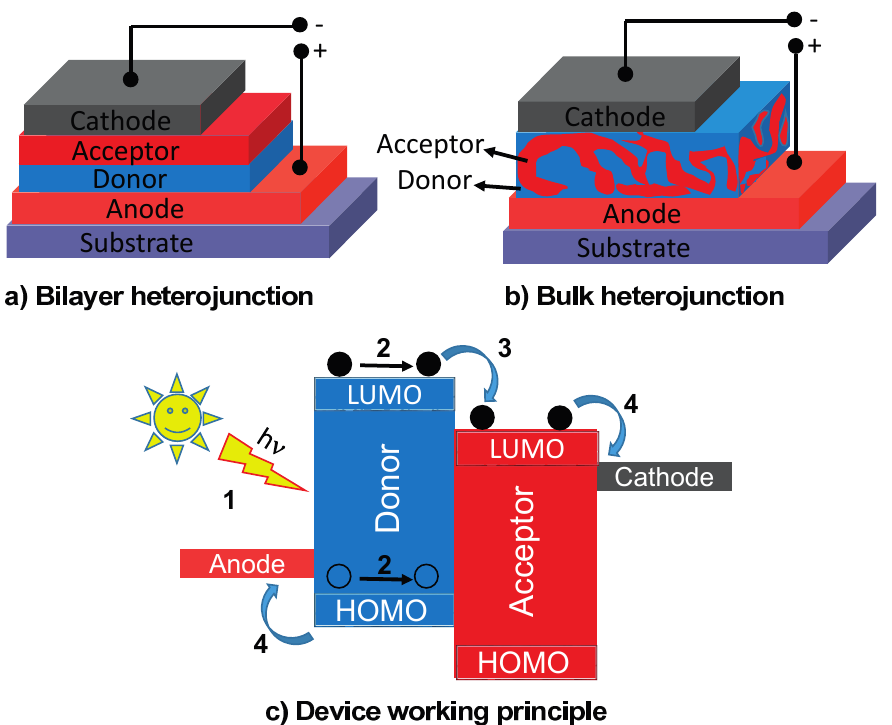
Figure 1. Device structures of ( a ) bilayer heterojunction, ( b ) bulk heterojunction, ( c ) device working principle from light absorption to charge